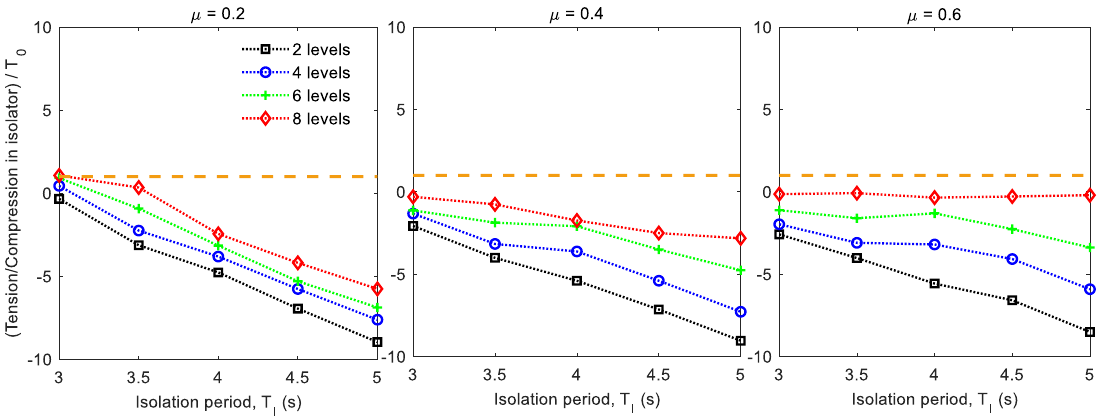
Figure 17. Ratio between the maximum axial load (traction > 0) or minimum axial load (compression < 0) on the isolator and the initial tension of the elastic element inside the insulator ( T 0 ). Orange segmented line refers to the value of 1. Input in the longitudinal direction of the rack.